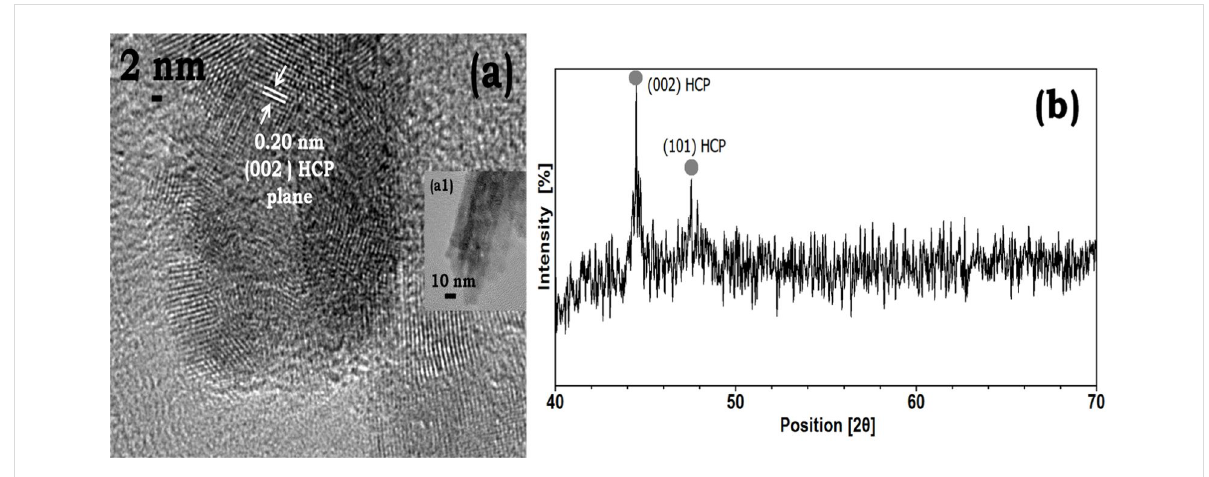
Figure 7: Co-TMAH nanorods obtained at 50 °C. (a) High-resolution image of a small section from inset (a1) shows a lattice spacing of 0.20 nm, the surface is perpendicular to the (002) hcp plane and the rod is polycrystalline; (b) X-ray diffraction spectrum of cobalt-TMAH-rods taken after 45 min. The larger intensity of the (002) reflection is in agreement with the lattice fringe spacing obtained along the length of the rods.